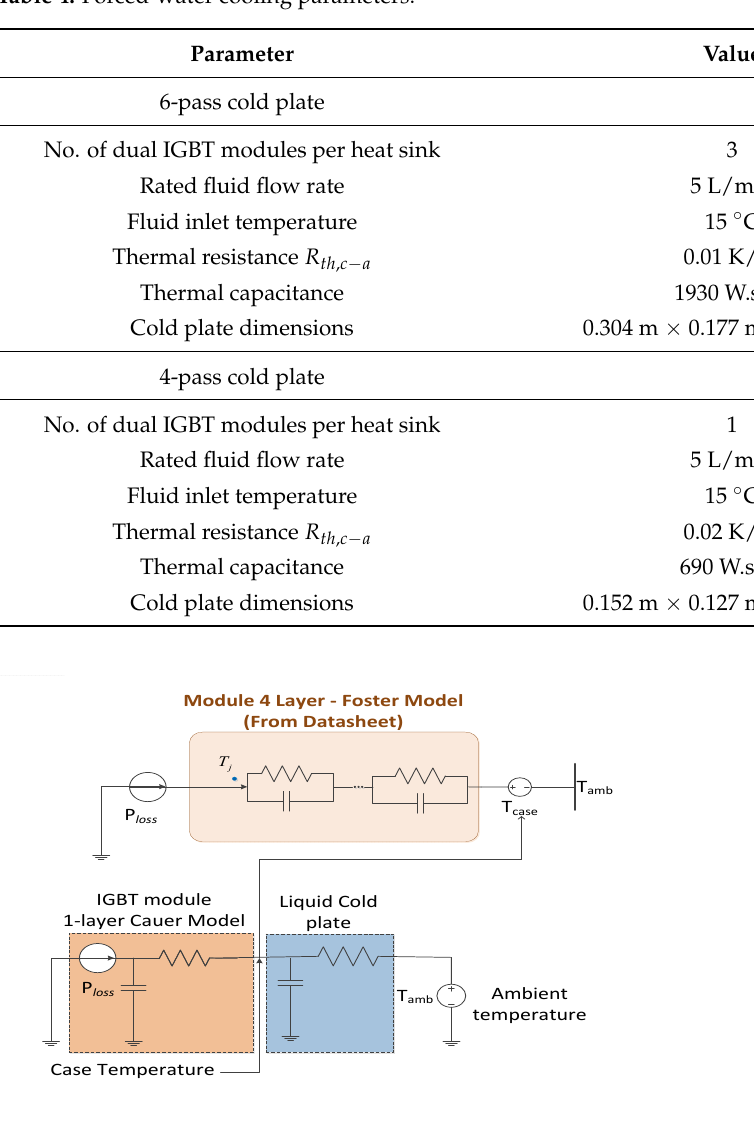
Figure 13. Thermal circuit for determining IGBT and diode junction temperatures in an actively cooled converter, adapted from [5]. T j , shown in the figure, is the junction temperature of interest in the lifetime model used in this paper. This T j can correspond to either the junction temperature of the IGBT or the diode, depending on which 4-layer Foster network is